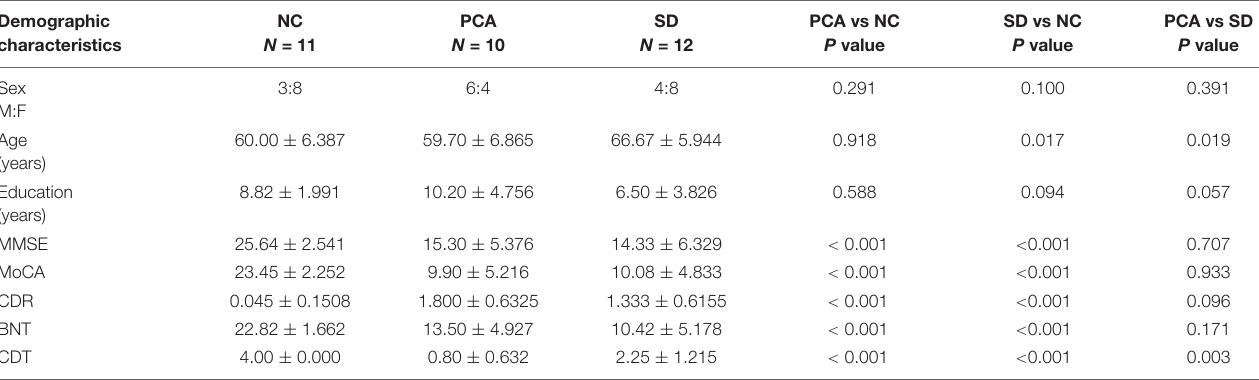
TABLE 1 | Demographic and neuropsychological data. Demographic